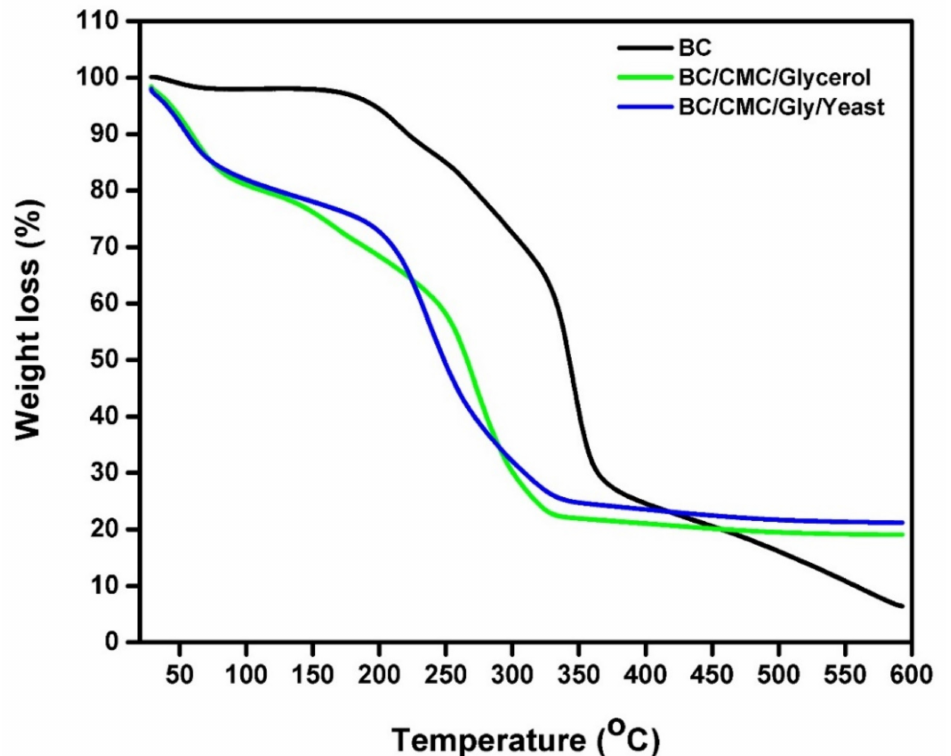
Figure 4. TGA curves of BC, BC/CMC/Gly, and BC/CMC/Gly/yeast